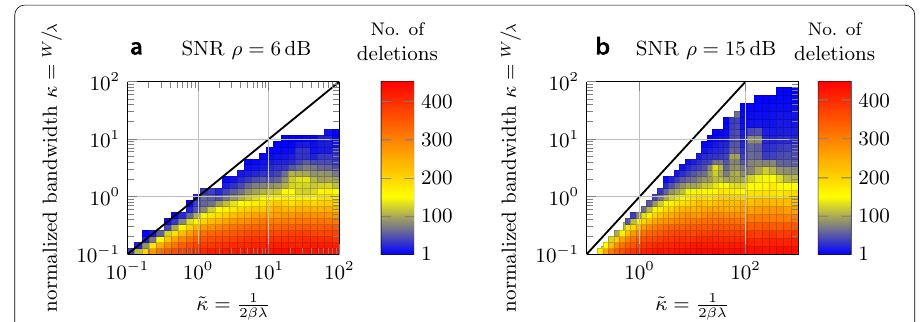
κ . In both parts of the figure, a W / (cid:31) and over ˜ = κ , i.e., W 1 /( 2 ≥ ˜ ≥